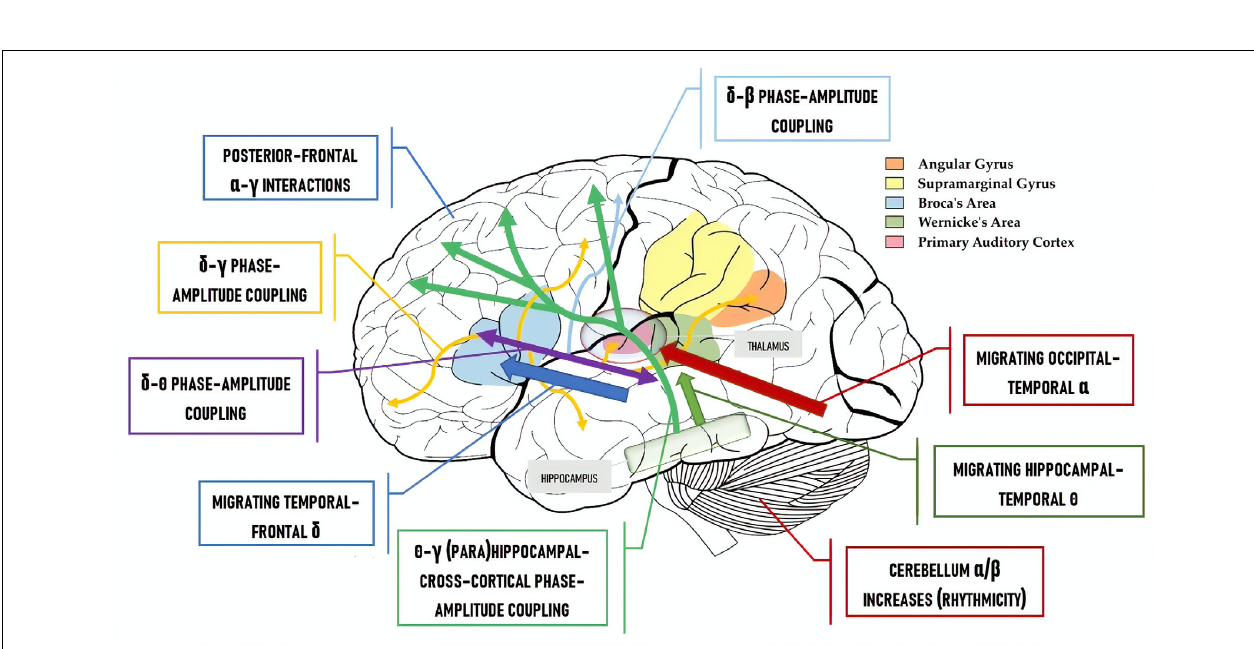
FIGURE 2 | The “Where” Question: a cartographic map of where the neural code for language is hypothesized to be implemented.